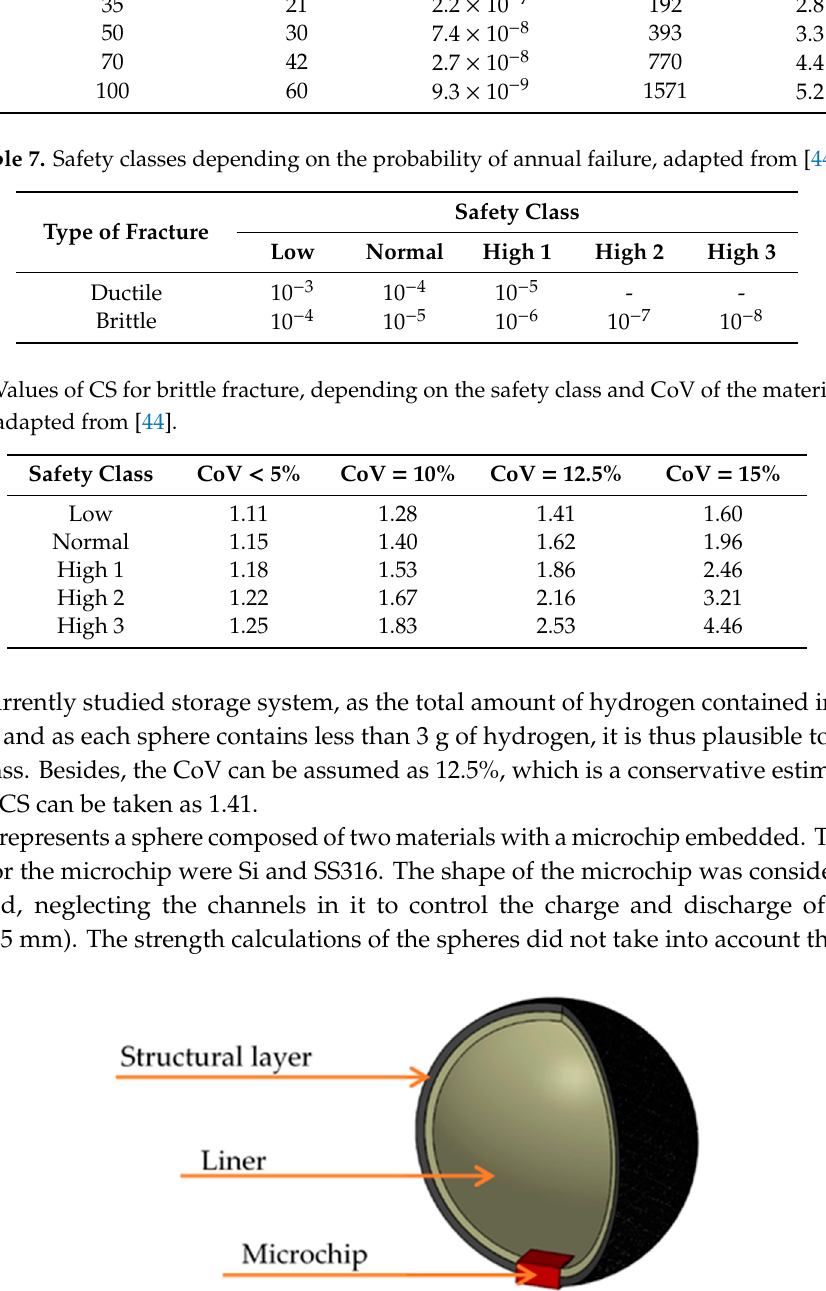
Table 7. Safety classes depending on the probability of annual failure, adapted from [44].